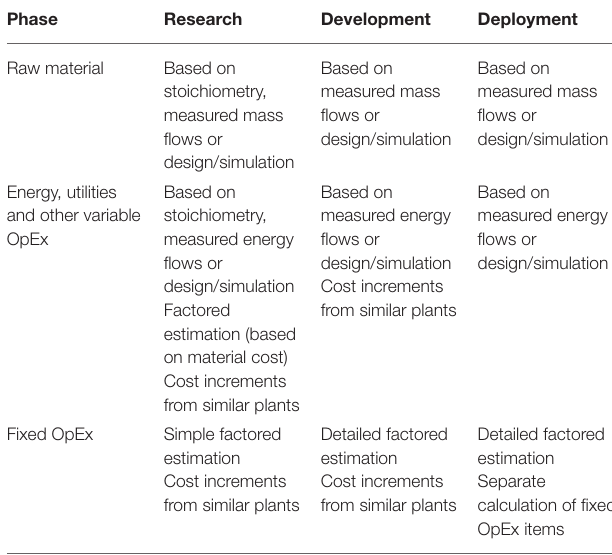
TABLE 5 | Overview of typical capital expenditure calculation methods. TABLE 6 | Overview of typical operational expenditure calculation